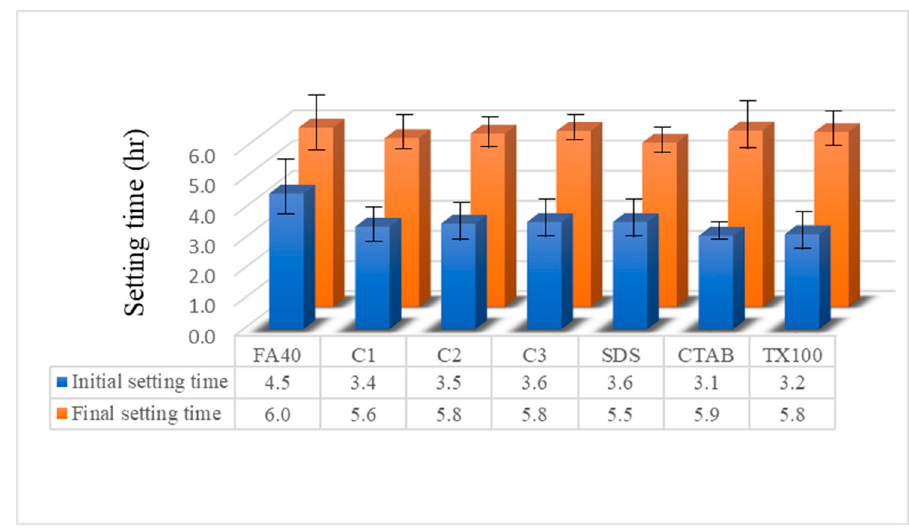
Figure 7. Effect of concentration and synthesized α -Fe 2 O 3 nanoparticles on setting time of FA blended cement